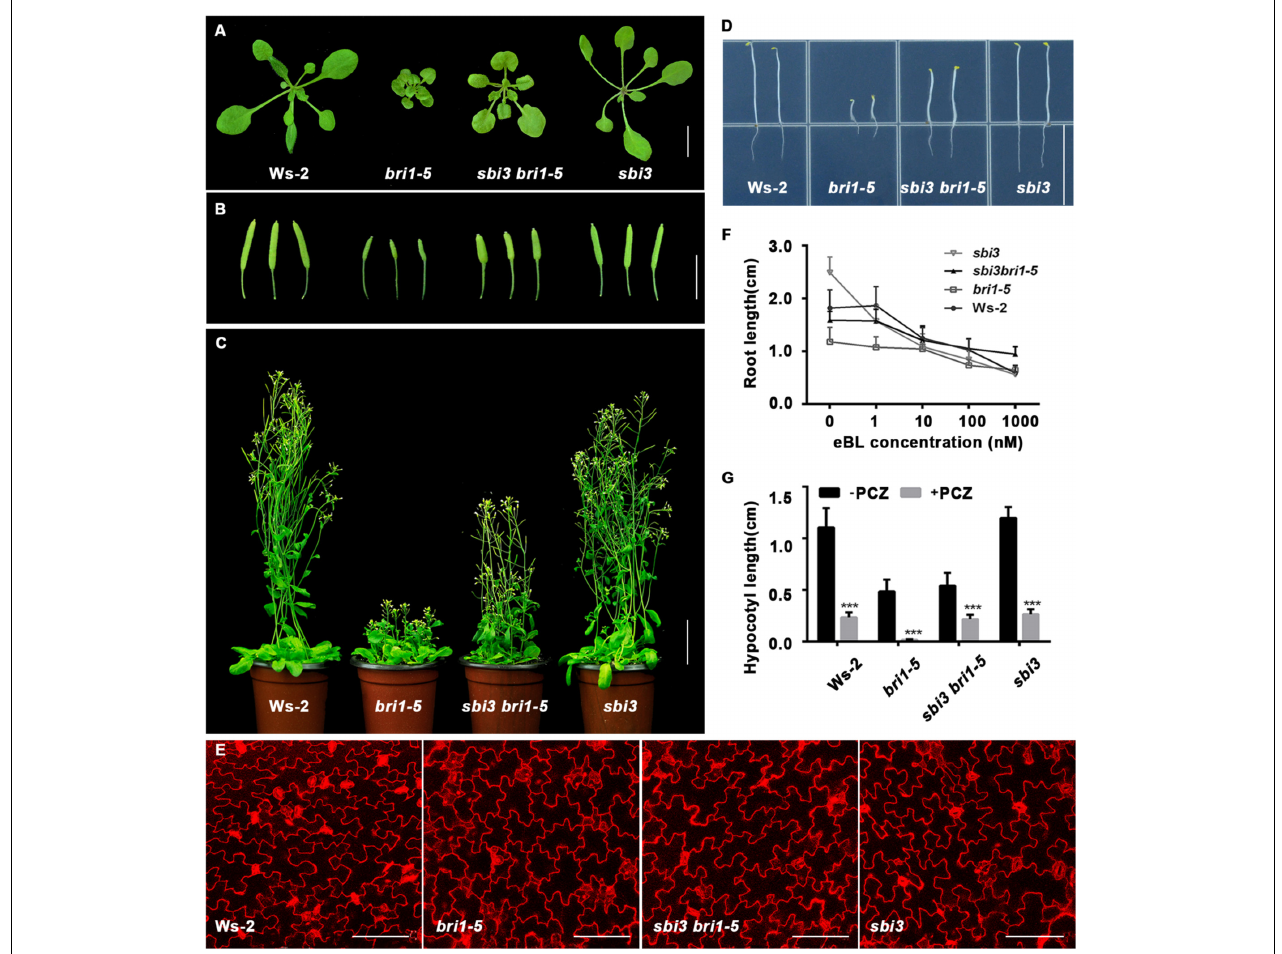
FIGURE 1 | sbi3 mutation partly suppresses bri1-5 dwarfism. (A) Phenotypes of 2-week-old soil-grown seedlings of Ws-2, bri1-5 , sbi3 bri1-5, and sbi3 . Scale bar, 1 cm. (B) 2-month-old siliques of Ws-2, bri1-5 , sbi3 bri1-5 , and sbi3 . Scale bar, 1 cm. (C) 2-month-old mature plants of Ws-2, bri1-5 , sbi3 bri1-5, and sbi3 . Scale bar, 3 cm. (D) Hypocotyl comparison of 5-day-old dark-grown seedlings of Ws-2, bri1-5 , sbi3 bri1-5, and sbi3 . Scale bar, 1.5 cm. (E) The morphology of cotyledon pavement cells of 7-day-old seedlings from Ws-2, bri1-5 , sbi3 bri1-5, and sbi3 . Cotyledons were stained by propidium iodide (PI). Scale bar, 100 µ m. (F) Root growth phenotypes of 8-day-old Ws-2, bri1-5 , sbi3 bri1-5 , and sbi3 seedlings grown in 1/2 MS medium with different 24-epibrassinolide (24-eBL) concentrations at 22 ◦ C under long-day (16/8-h light/dark) condition. Quantitative analysis of root length plotted as the line graph and displayed in panel (F) , n ≥ 30 seedlings. Error bar represents ± SD, three independent assays. (G) Hypocotyl growth phenotype of 5-day-old Ws-2, bri1-5 , sbi3 bri1-5 , and sbi3 seedlings grown in 1/2 MS medium treated with or without 5 µ M PCZ in the dark. Quantitative analysis of hypocotyl length of 5-day-old dark-grown seedlings plotted as histograms displayed in